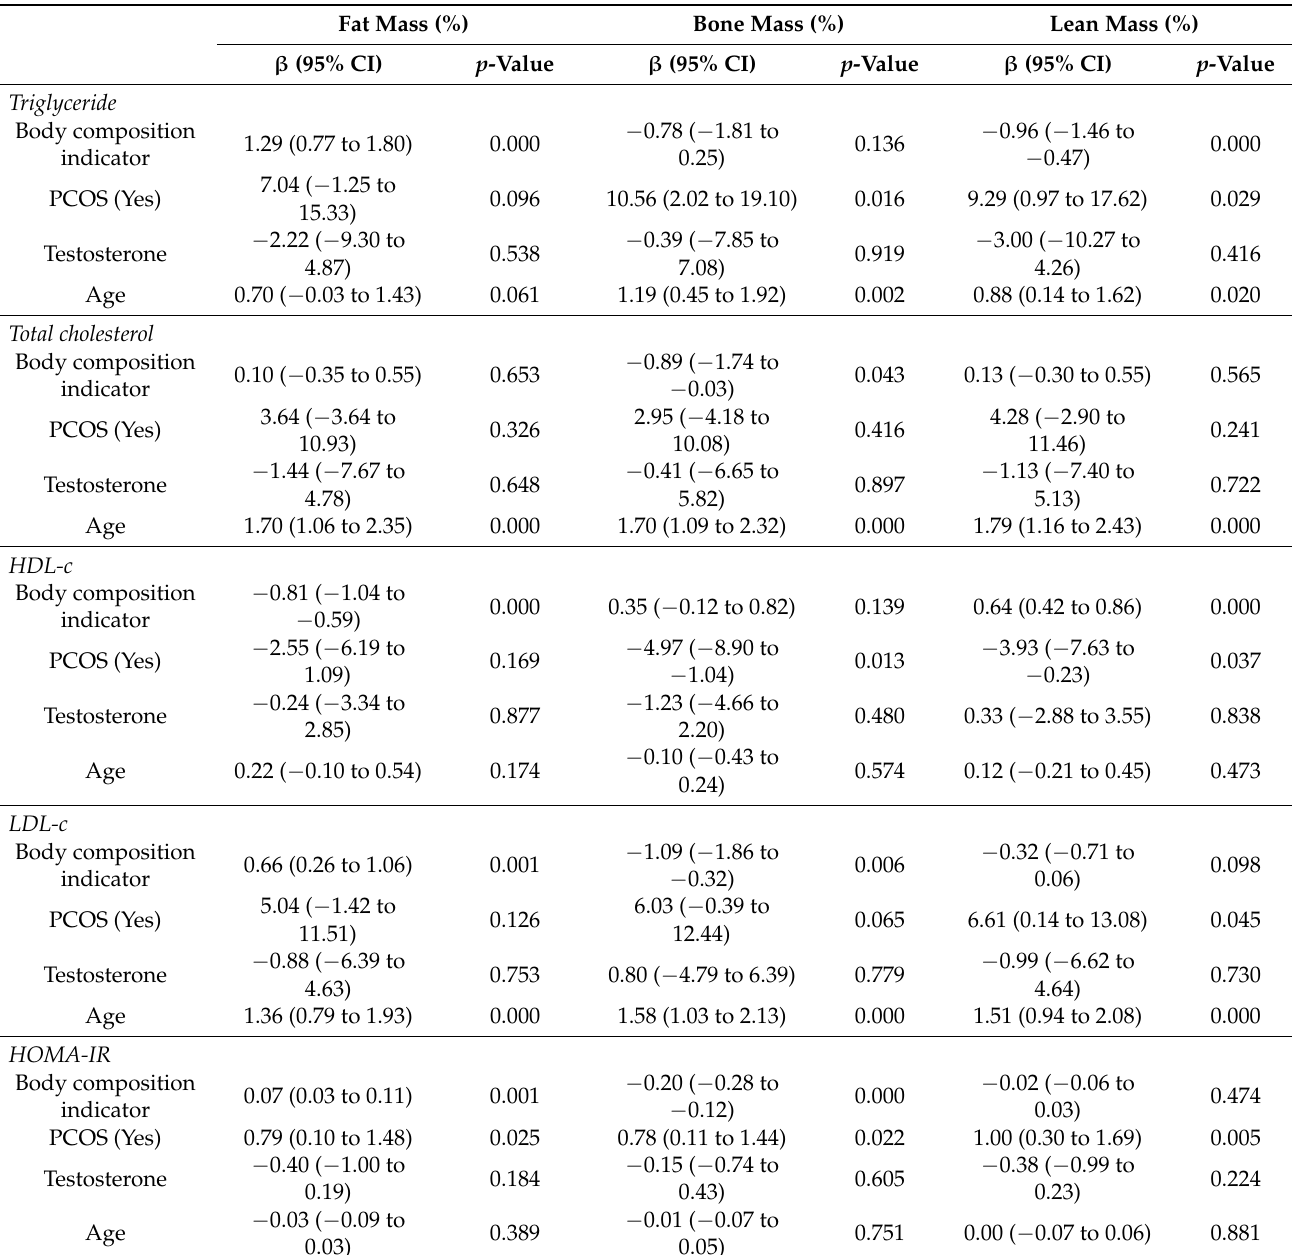
Table 3. Multivariate linear regression analysis for individual body composition measures as predictors of lipid profile in PCOS ( n = 126) and controls ( n =